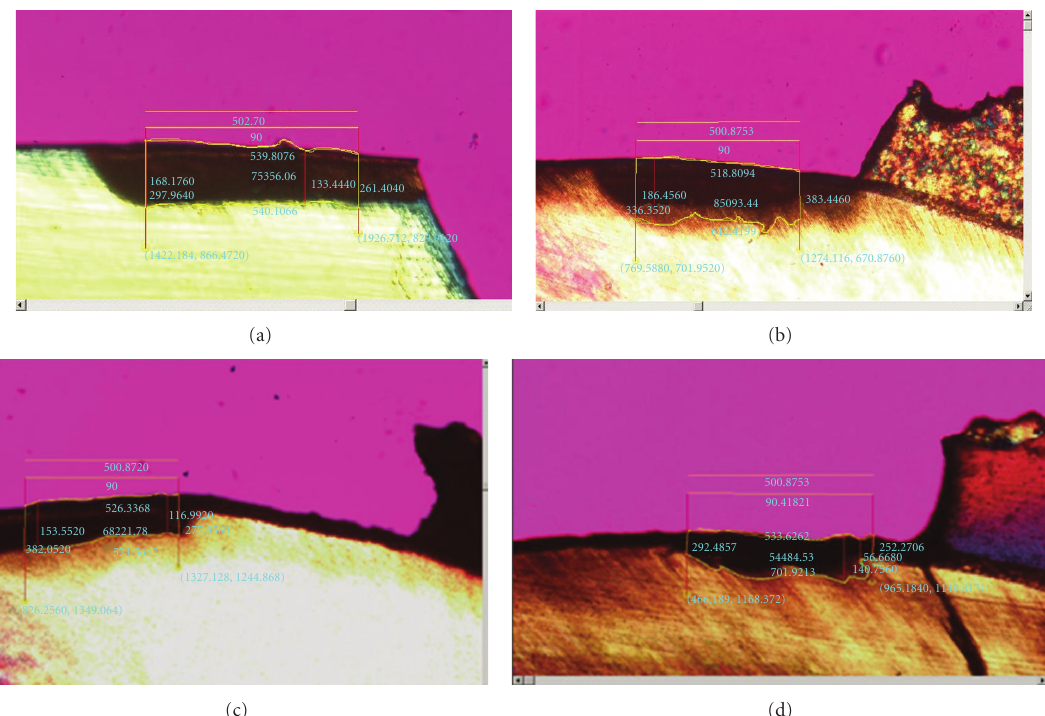
Figure 4: The photomicrographs obtained from polarized light microscopy show representative lesions of each group after 42 days of in vitro pH cycling: (a) control group without resin, (b) Transbond XT, (c) Quick Cure, (d) Aegis Ortho. Aegis Ortho had reduction of 20.3% as compared to the no adhesive control enamel group, whereas Transbond XT had an increase in lesion depth area of 3.2% versus the control group.